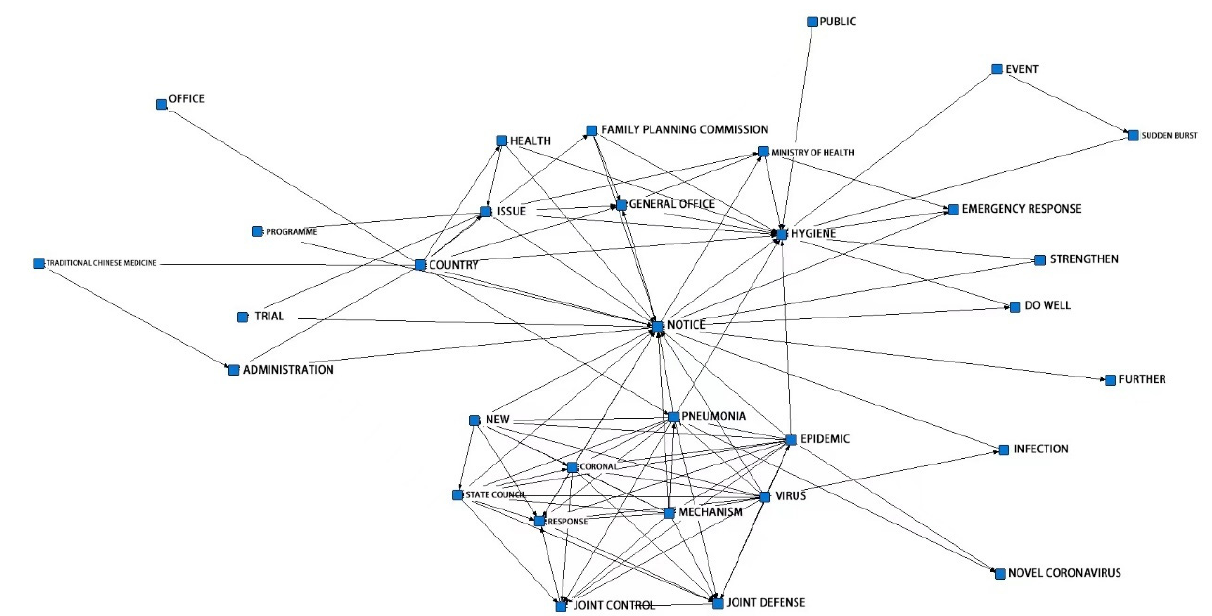
Figure 5. Semantic network analysis result.